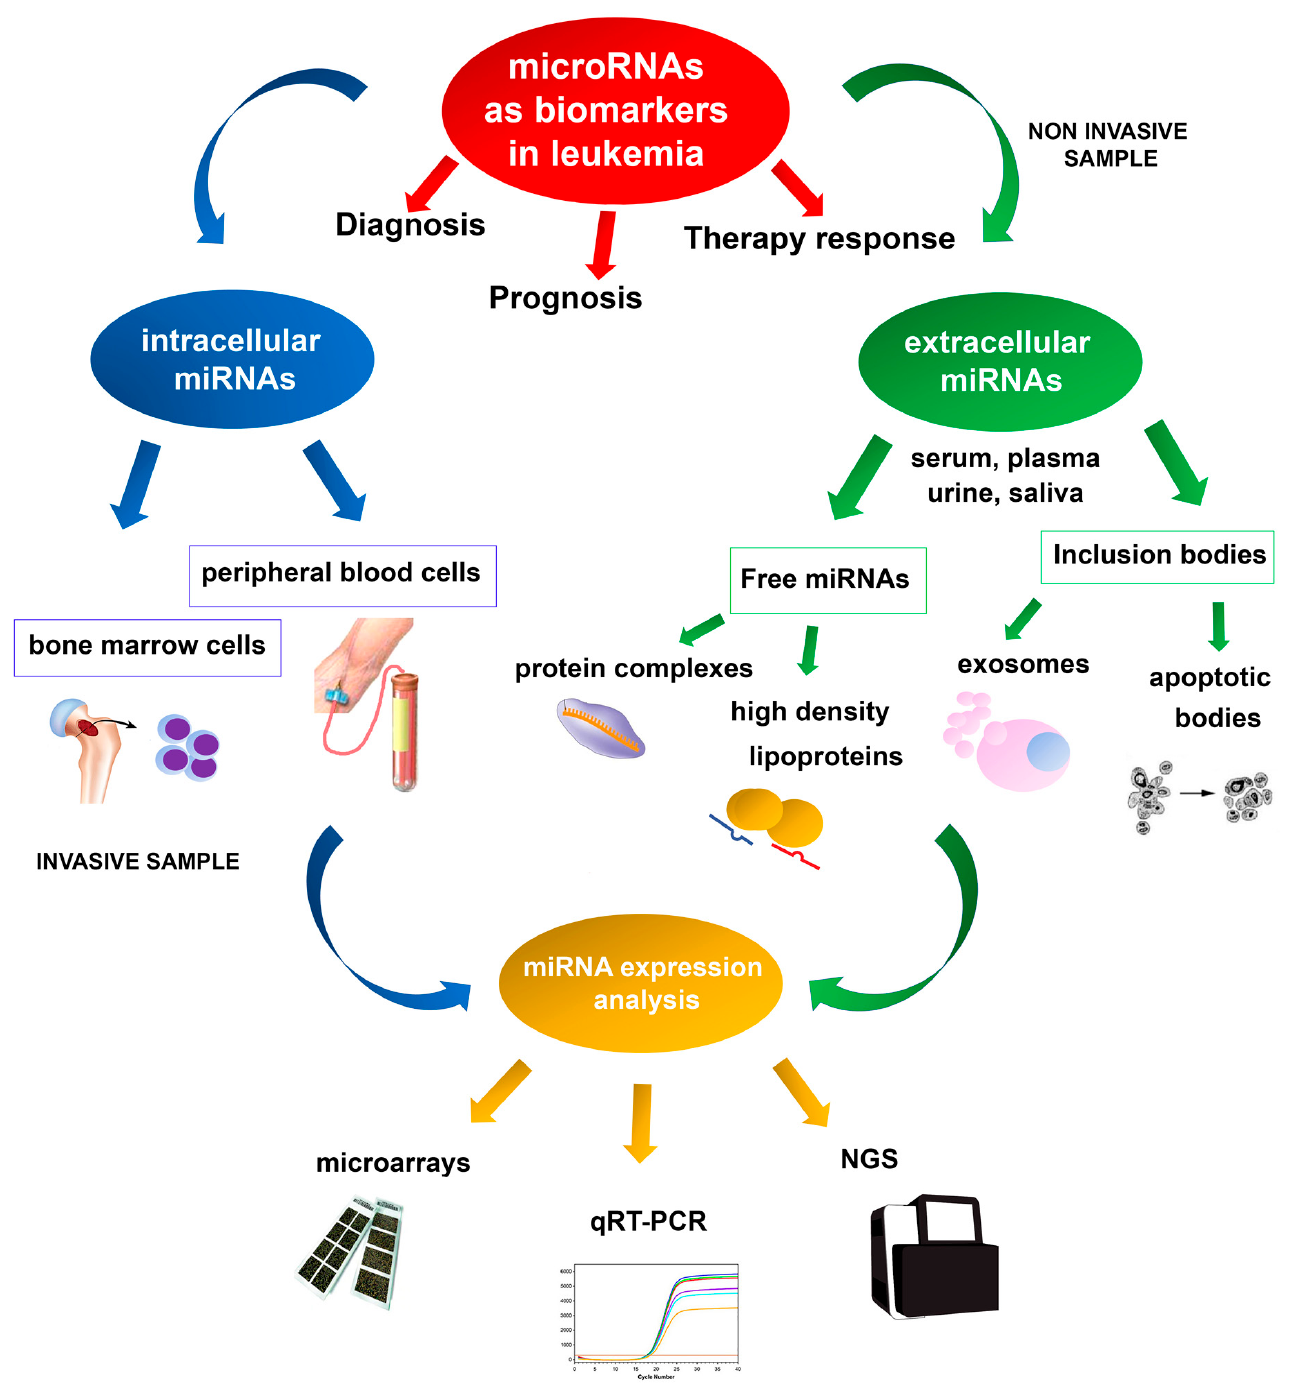
Figure 1. Schematic representation of miRNA employment as biomarkers in leukemia, based on invasive and non-invasive approaches for expression